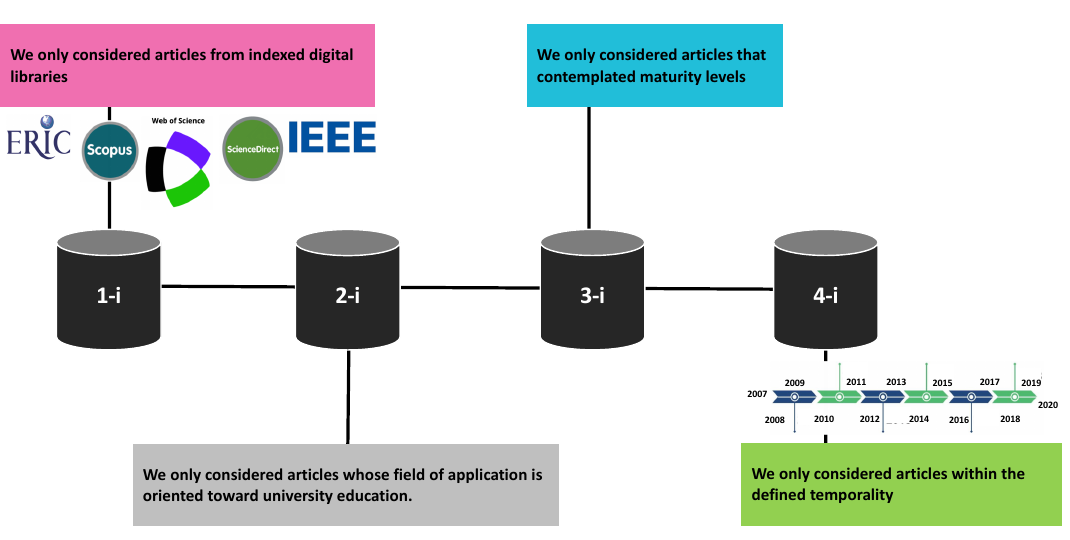
Figure 2. Inclusion criteria. In this condition, articles, conference papers, reviews and conference reviews were selected, all in English.